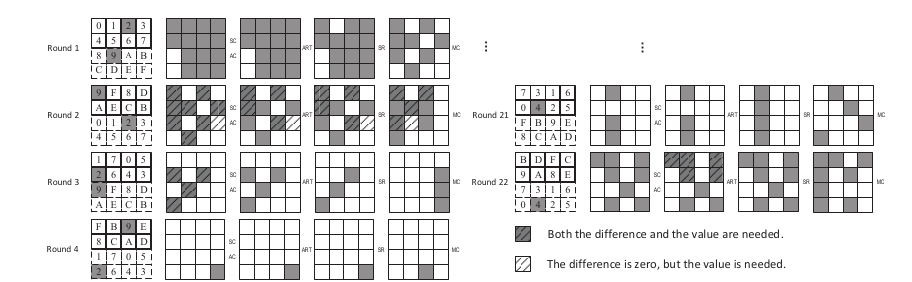
Figure 10: Tweakey recovery attack of 22-round SKINNY-128-256 using a 18-round related-tweakey rectangle distinguisher from Round 4 to Round 21 By extending 2 rounds backward and 2 rounds forward, we get following parameters: r b = 13 c, t b = 8 c, m b = 6 c , r f = 16 c, t f = 13 c, m f = 12 c where c = 4. Consequently,